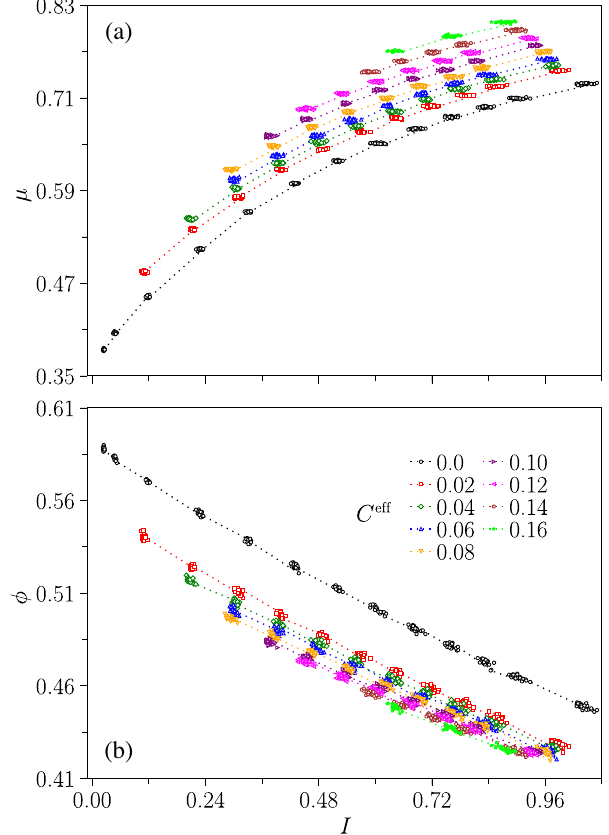
FIG. 3. Rheology of homogeneous flows. Variation of (a) the friction coefficient μ and (b) the volume fraction ϕ with the inertial number I for different values of the effective cohesion number C eff . Data are obtained using n ¼ 12 000 grains during the steady shear rate up sweep. Dotted lines are guides to the